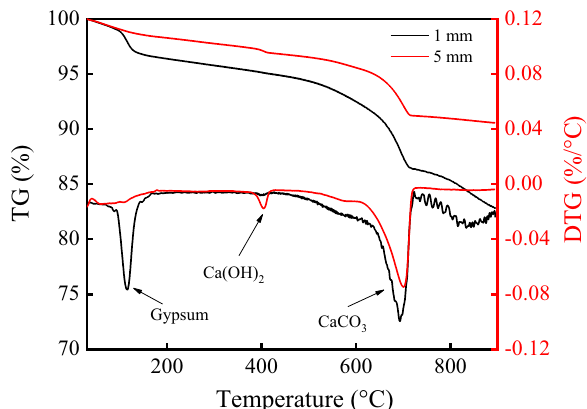
Figure 11. Thermal analysis curves of concrete under the action of CO 2 and SO 2